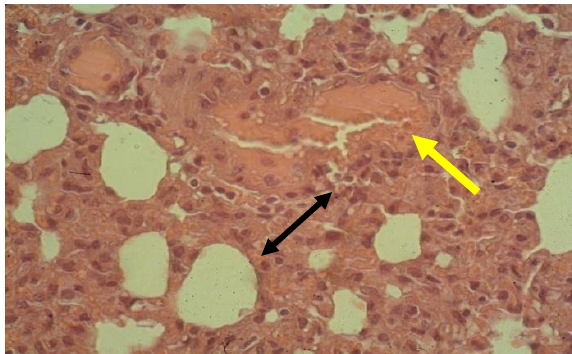
Figure, 3: lung of sheep infected by Toxoplasma gondii shows increased thickness of intra alveolar septa of the lung due to congested blood vessel ( ) and inflammatory cells infiltration ( ) (H and EX400